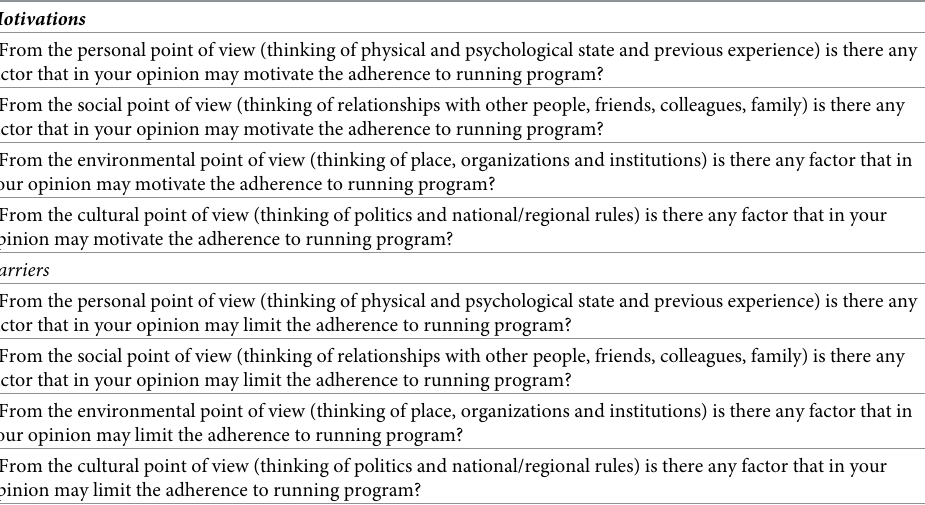
Table 1. Semi-structured interview